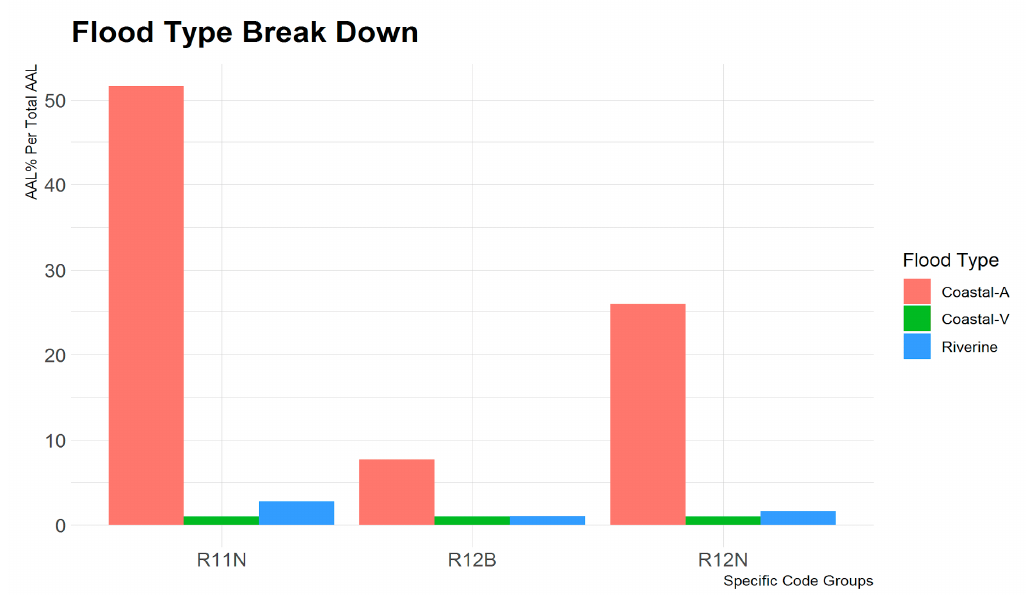
Figure 7. The breakdown of expected annual loss for di ff erent groups of flood type in 3 property’s specific building codes that indicate highest values; typical 1-story buildings with no basement (R11N) are showing the highest proportion among different groups.